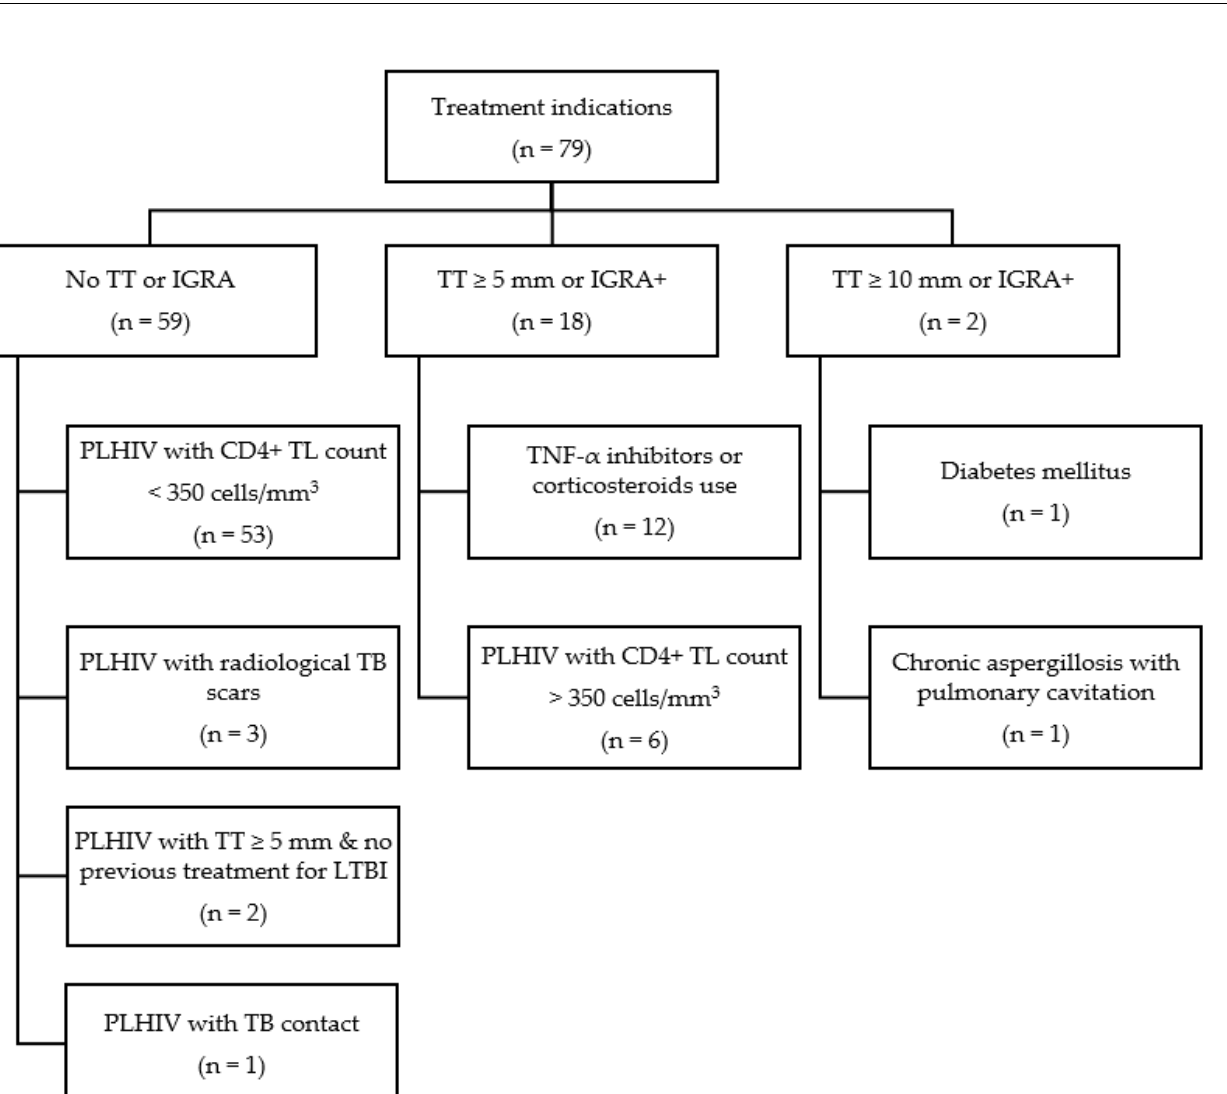
Figure 1. Flowchart of indications for LTBT in a Brazilian tertiary center from 2017 to 2019. CD4 + TL, CD4 + T lymphocyte; DM, diabetes mellitus; IGRA, interferon gamma release assay; LTBI, latent tuberculosis infection; PLHIV, people living with HIV; TB, tuberculosis; TT, tuberculin test.